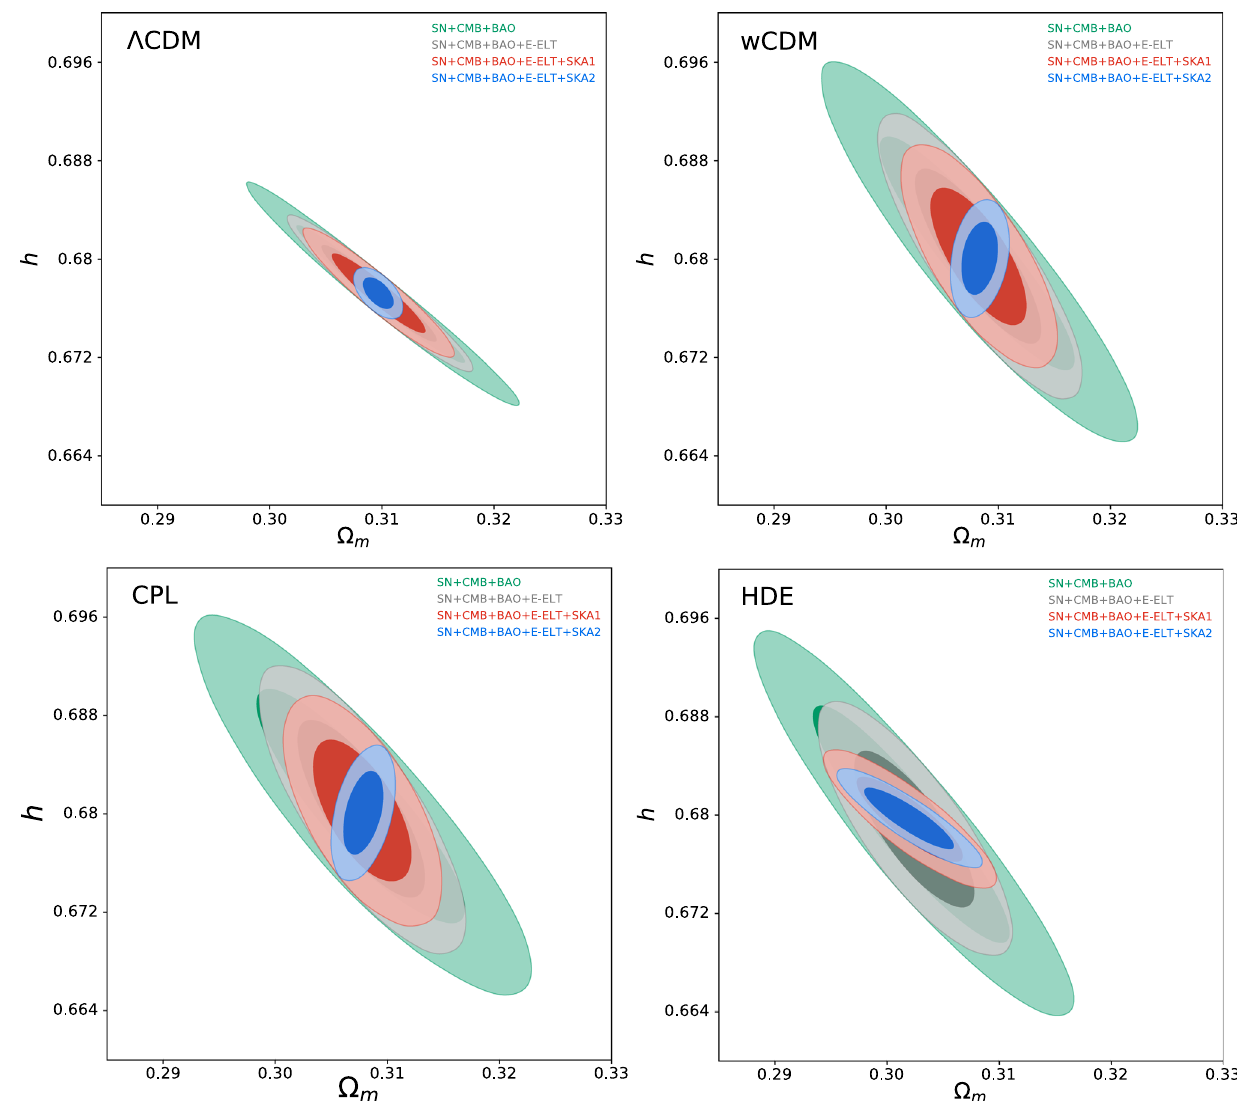
Fig. 4 Constraints (1 σ and 2 σ CL) on (cid:2) CDM, w CDM, CPL, and HDE models from the SN+CMB+BAO, SN+CMB+BAO+E-ELT, SN+CMB+BAO+E-ELT+SKA1, and SN+CMB+BAO+E-ELT+SKA2 data in the (cid:4) m – h